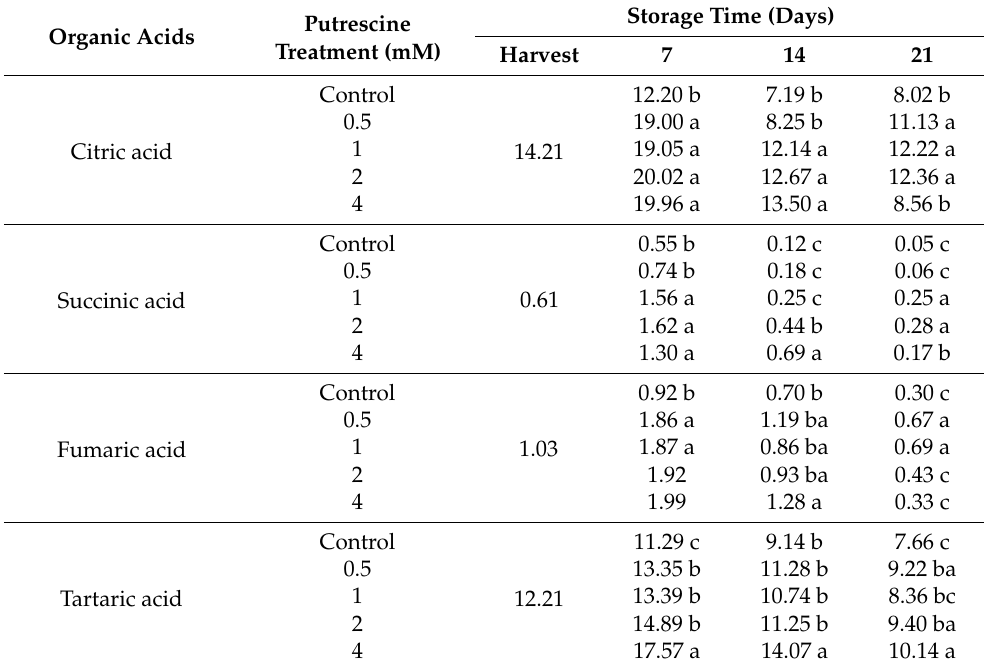
Table 3. Effect of putrescine treatment on organic acids (mg/100 g FW) contents of fig fruits during cold